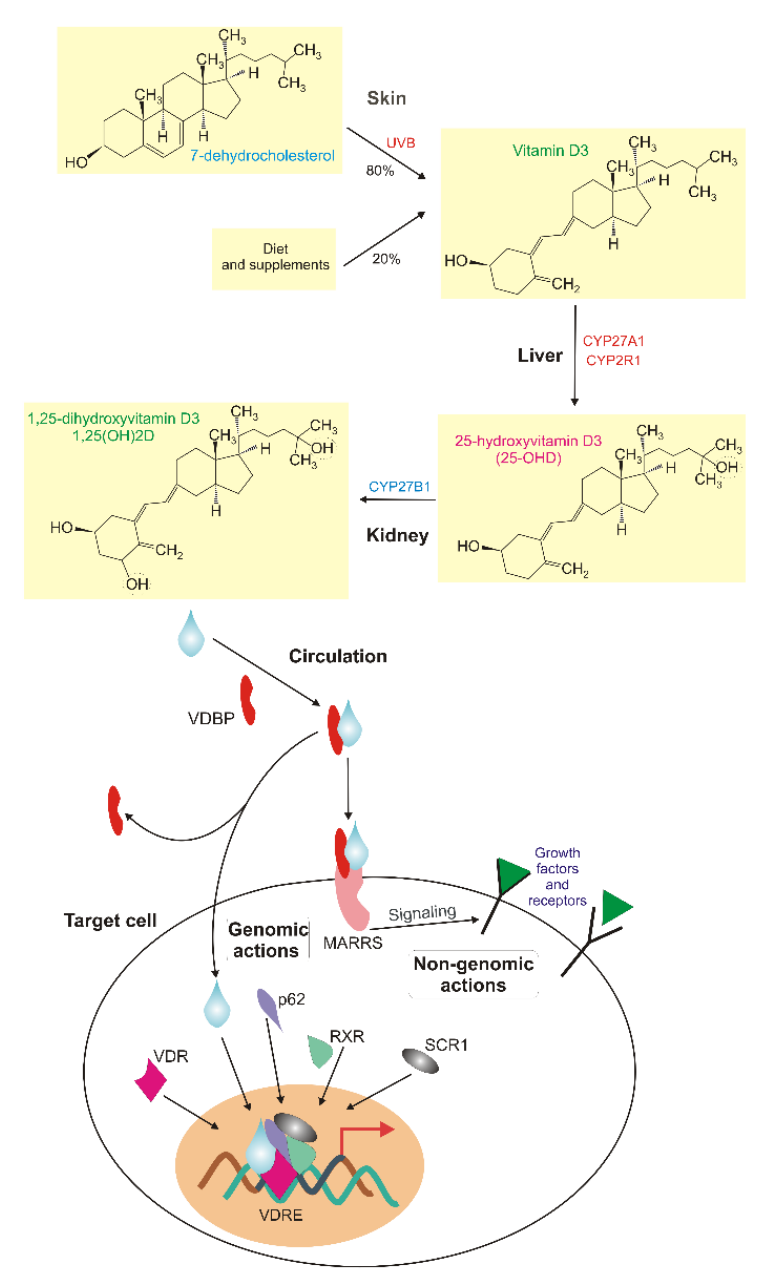
Figure 1. Vitamin D metabolism and effects in humans. Vitamin D3 is synthesized in skin from 7-dehydrocholesterol in a reaction catalyzed by solar UVB and can be delivered with food. In the circulation, it is bound by vitamin D binding protein (VDBP) and can reach liver, where is metabolized by cytochrome P450 family 2 subfamily R member 1 and family 27 subfamily A member 1 (CYP2R1 and CYP27A1) to 25-hydroxyvitamin D3 (25(OH)D), which is converted by CYP24A1 to 1,25-dihydroxyvitamin D3 (1,25(OH)2D, a blue tear) in a reaction that occurs mainly in kidney microtubule. 1,25(OH)2D is a biologically active metabolite of vitamin D that may interact with its transmembrane membrane-associated rapid response steroid-binding (MARRS) receptor and affect signaling, nuclear proteins and other transmembrane receptors, including growth factors (non-genomic action). 1,25(OH)2D may associate with its nuclear receptor Vitamin D receptor (VDR), which induces its heterodimerization with retinoid X receptor (RXR) and binding other proteins, including sequestosome 1 (p62/SQSTM1) and steroid receptor coactivator 1 (SRC1), to bind vitamin D response elements in the promoters of hundreds of genes to regulate their expression (genomic action).